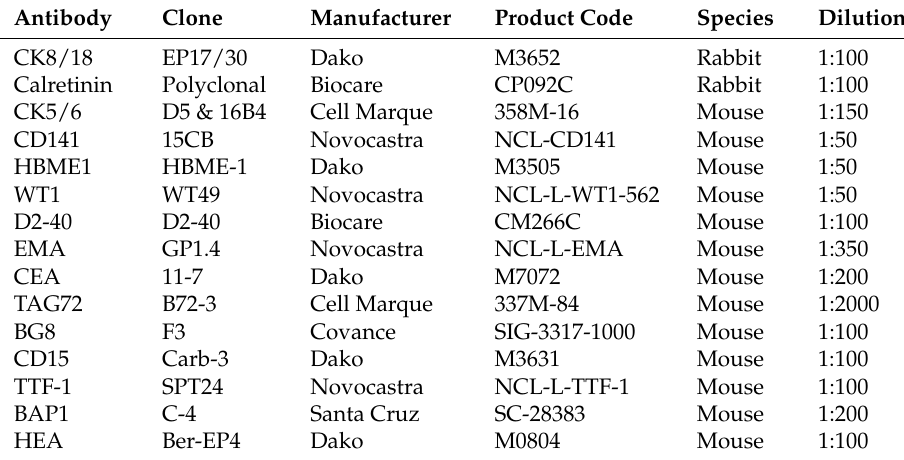
Table 4. Antibodies used in this